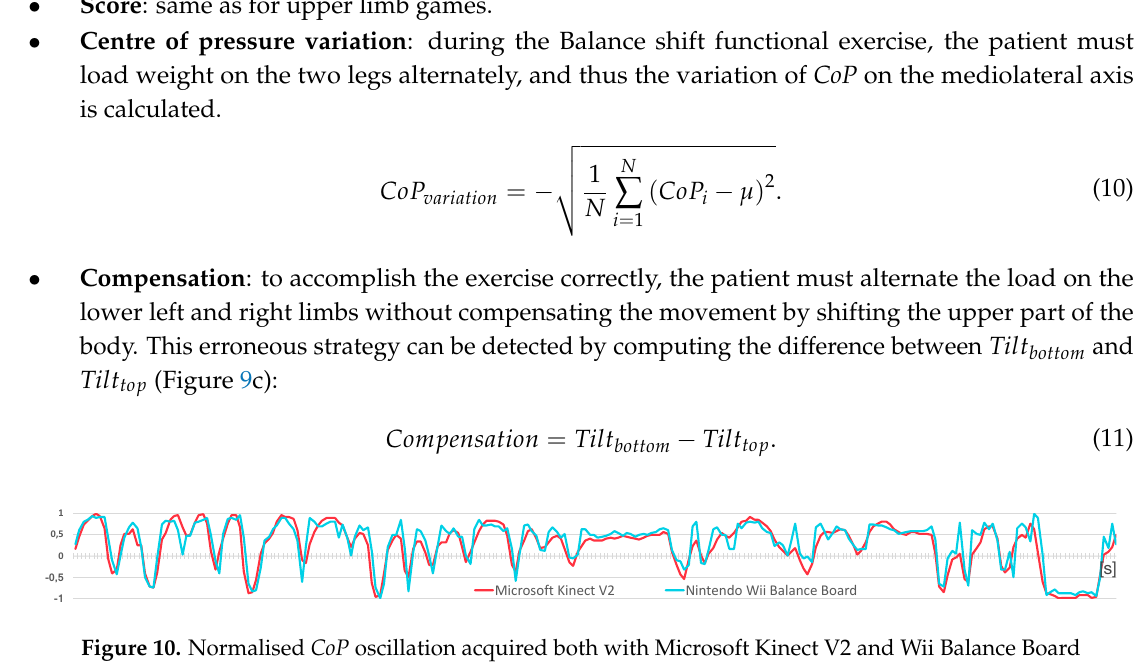
Figure 10. Normalised CoP oscillation acquired both with Microsoft Kinect V2 and Wii Balance Board during a comparison test. Time is on the x -axis (2-min-long trial).